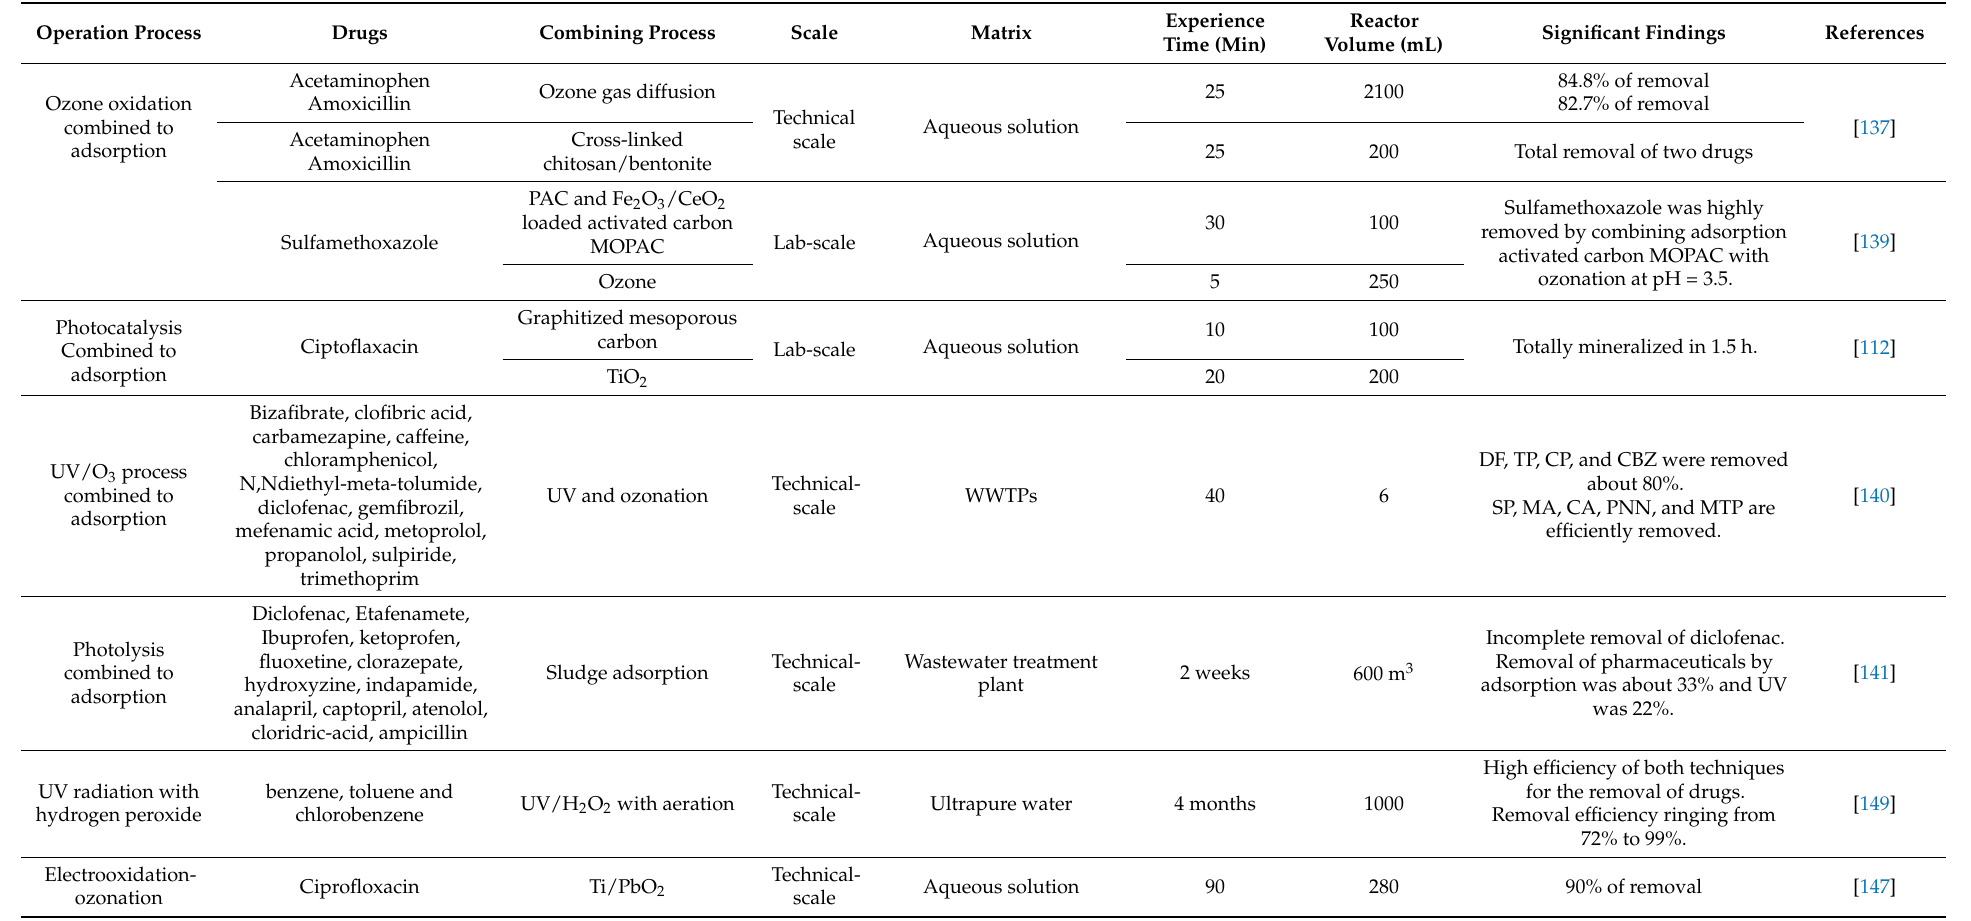
Table 4. Removal of different drugs by combined